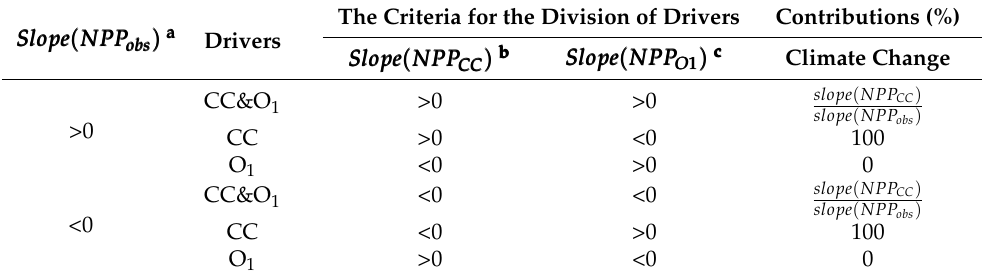
Table 1. Contributions of climate change to NPP